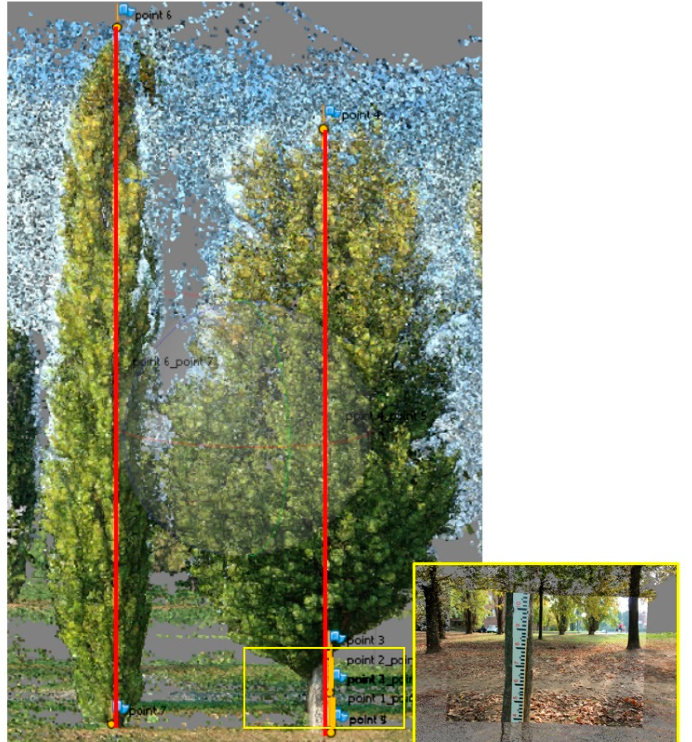
Figure 6. Three-dimensional model of sample plot 4. The blue flags are the added markers, and the yellow lines (on right-side tree’s lower trunk) are the segments on the reference bar (the yellow box shows the reference bar) used to constrain the reconstruction, while the red lines are the segments created for H estimation.